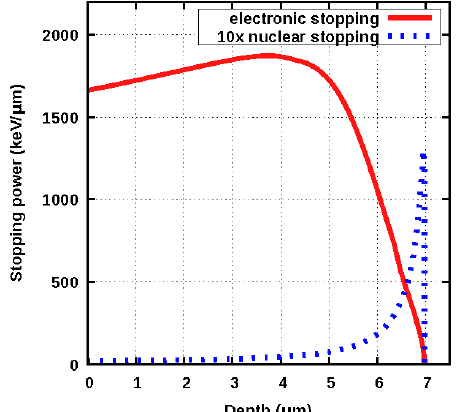
Figure 3. Electronic (red line) and nuclear (dotted blue line) energy loss vs. depth in an Er: tungsten- tellurite glass irradiated with 11 MeV C 4+ ions. Note that nuclear energy loss was multiplied by 10 for better visibility